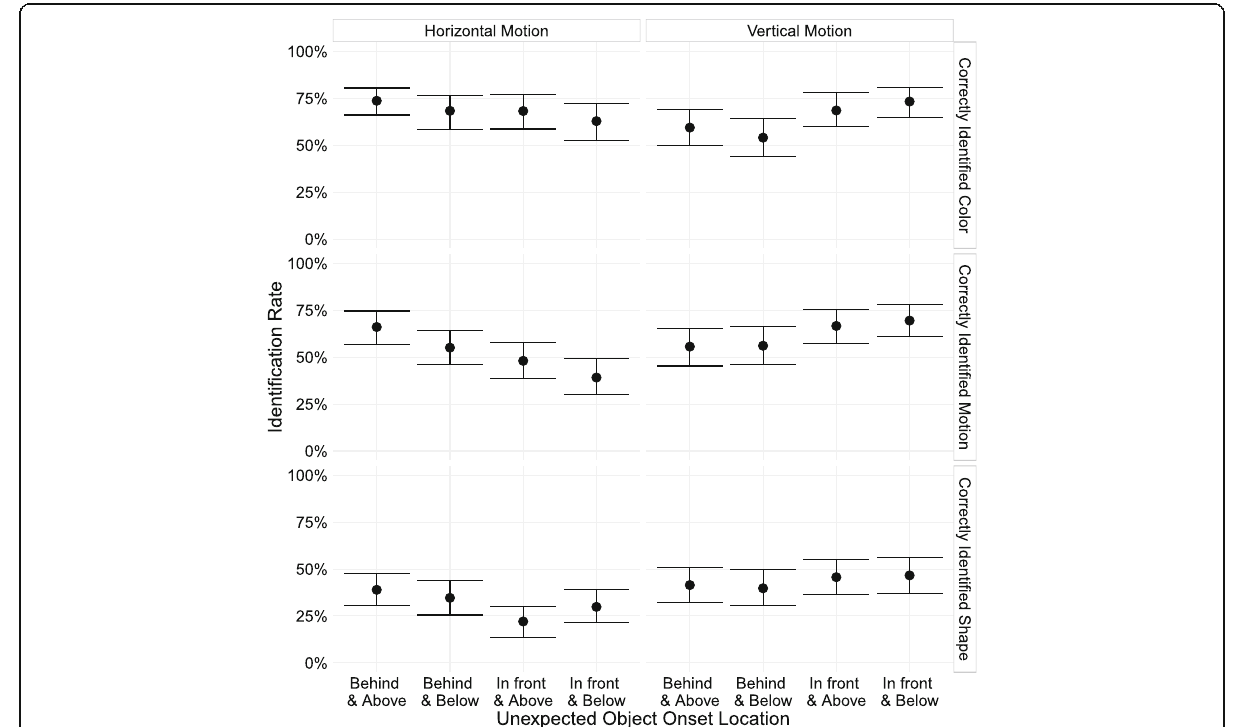
Fig. 4 Rate at which subjects who reported seeing a new object correctly identified the unexpected object ’ s features, broken down by each possible position and motion trajectory. Error bars are 95% bootstrapped confidence intervals. To be counted as correctly identifying a feature of the unexpected object, subjects had to report noticing something new, and: for color, report that the new object was green; for motion, select the correct trajectory; and for shape, report that it was a